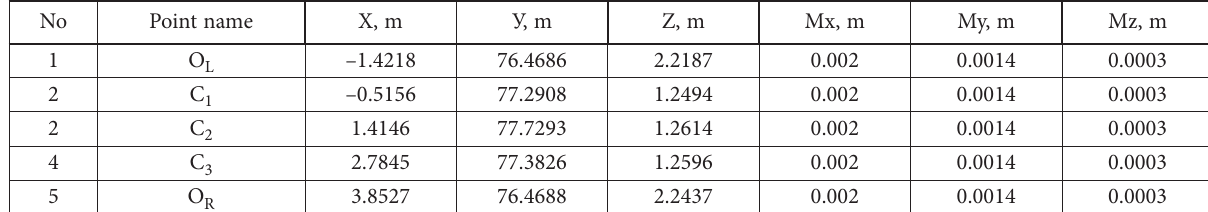
Table 2. Coordinates of reference points and their errors